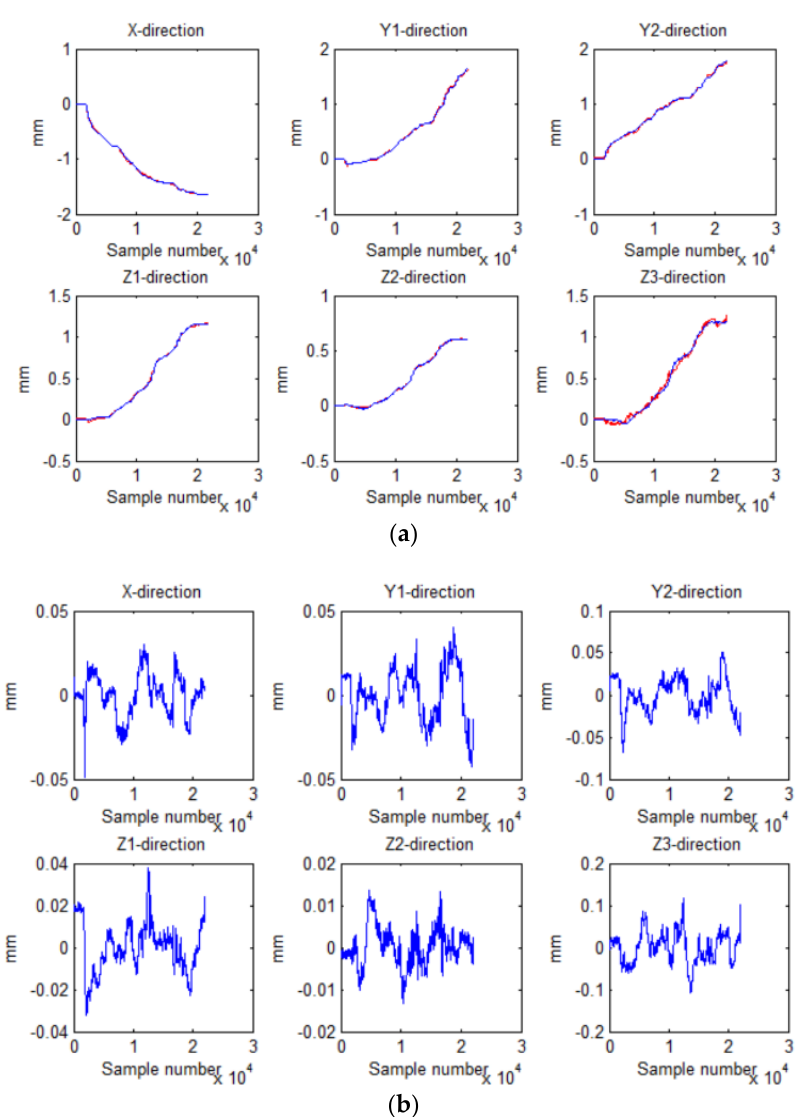
Figure 9. Displacement of the Hall sensors deduced by of the displacement of laser sensors and multidimensional fitting: ( a ) displacement obtained by two ways; ( b ) difference between the two displacements.